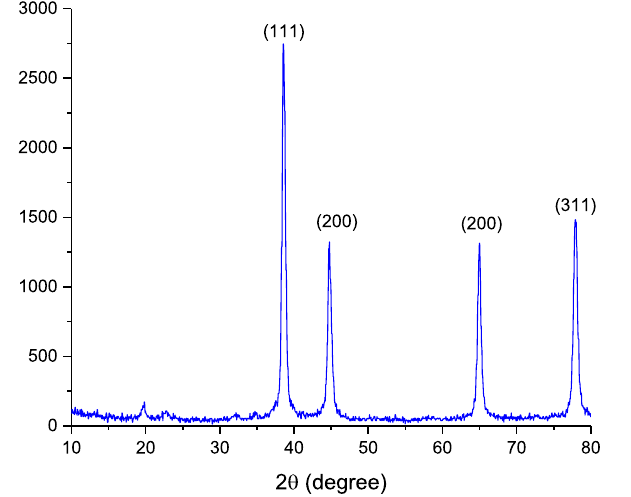
Figure 2. PXRD pattern of Ag–CP.